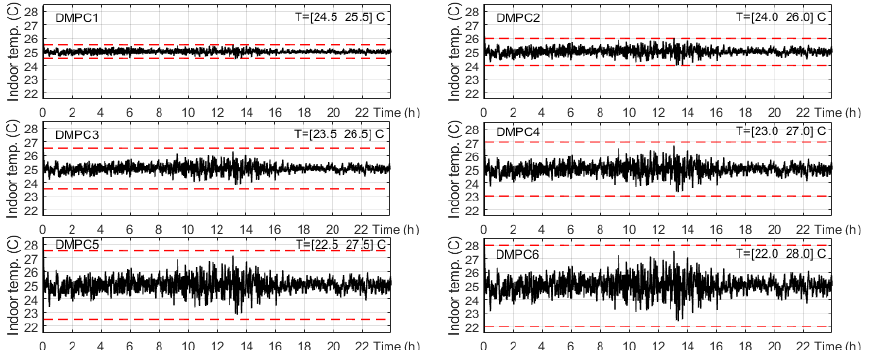
Figure 13. Indoor temperature deviation of the DMPCs for IAC control of case 2.